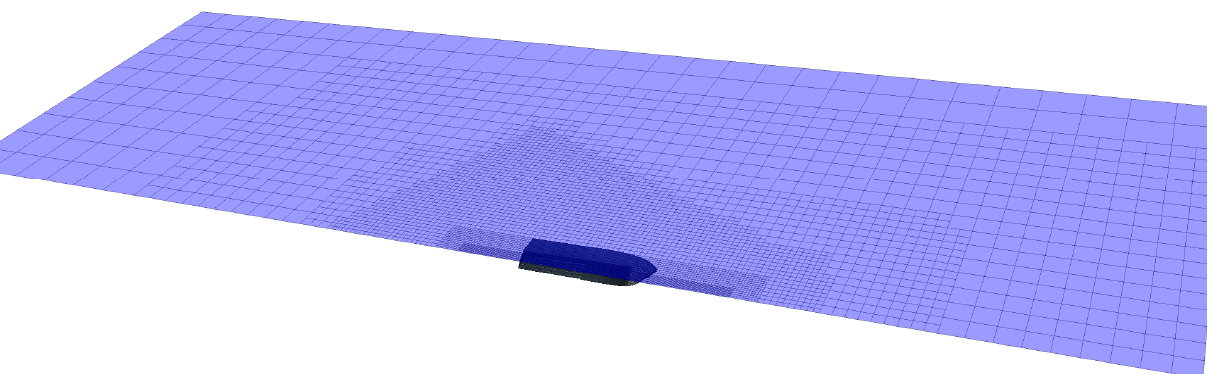
Figure 7. Kelvin refinement.